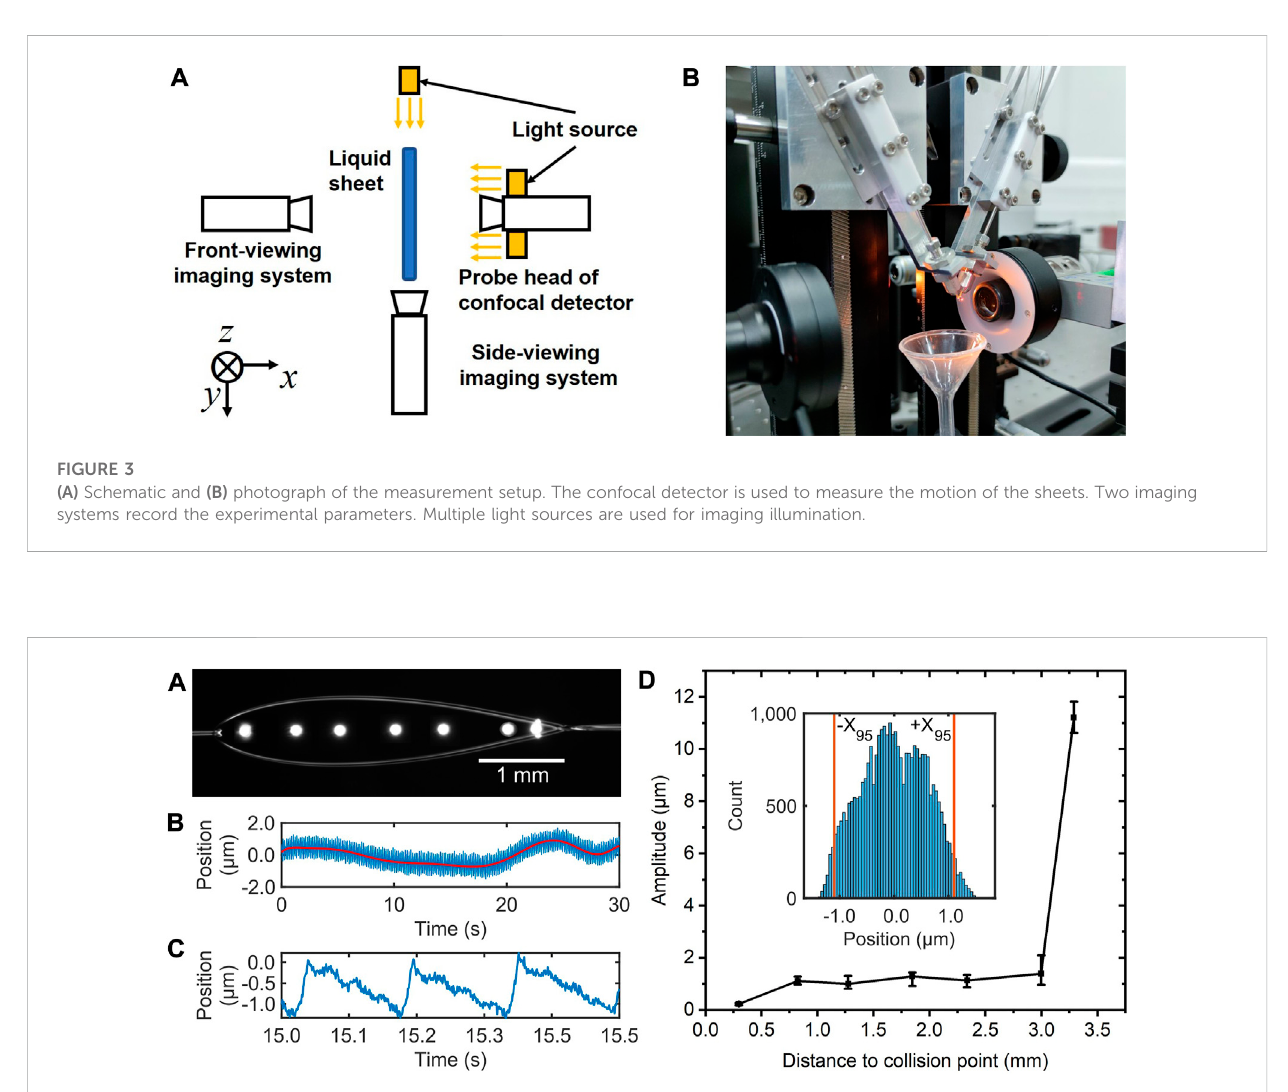
FIGURE 4 (A) The arrangement of the measurement points in a typical experiment. (B) Raw data of the motion of a liquid sheet corresponding to one measurementatacertainpoint. (C) Azoom-inof (B) . (D) Themotionamplitudeofthesheetasafunctionofthedistancetothecollisionpoint.Theinsetin (D) is the typical histogram of one measurement, where two vertical lines indicate the threshold X 95